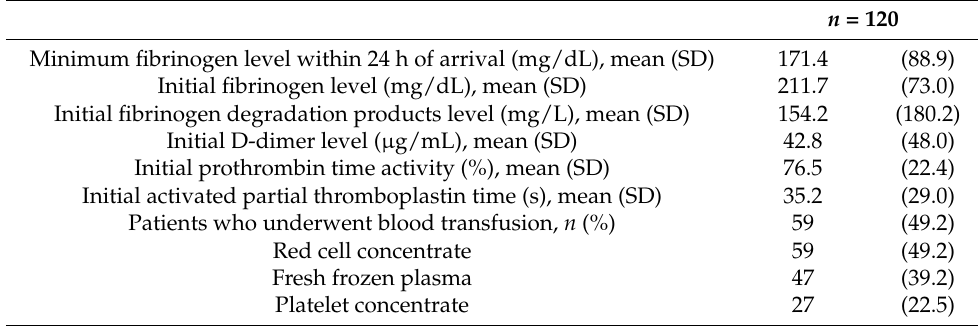
Table 2. Results of coagulation parameters and requirement of blood